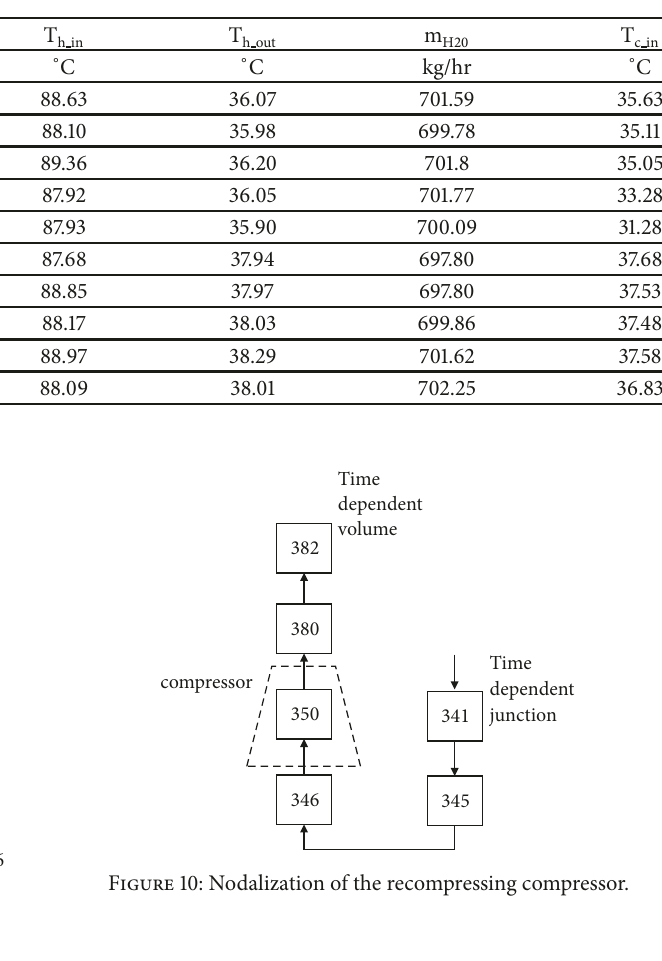
Table 3: Details of the experimental conditions.